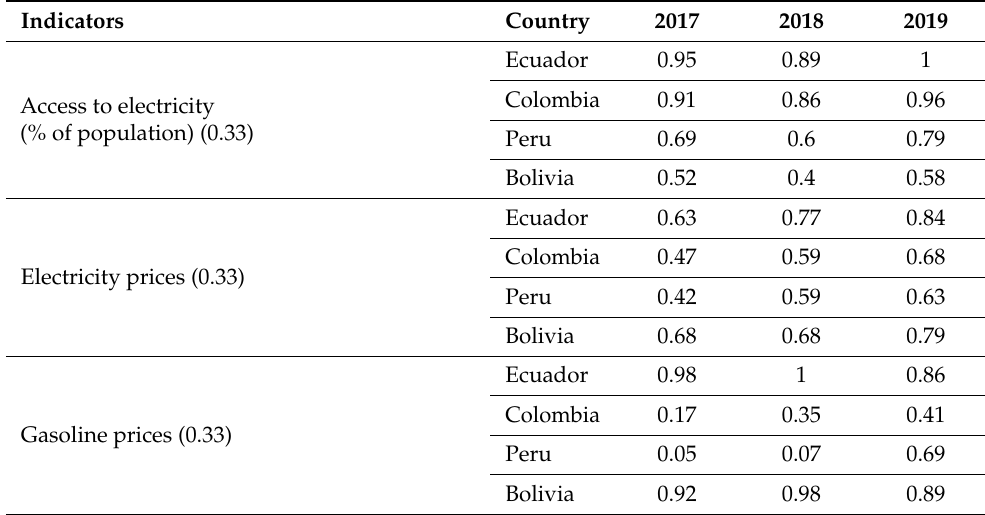
Table 7. The key indicators of the energy equity dimension in the members of the Andean Community (scores). Indicators